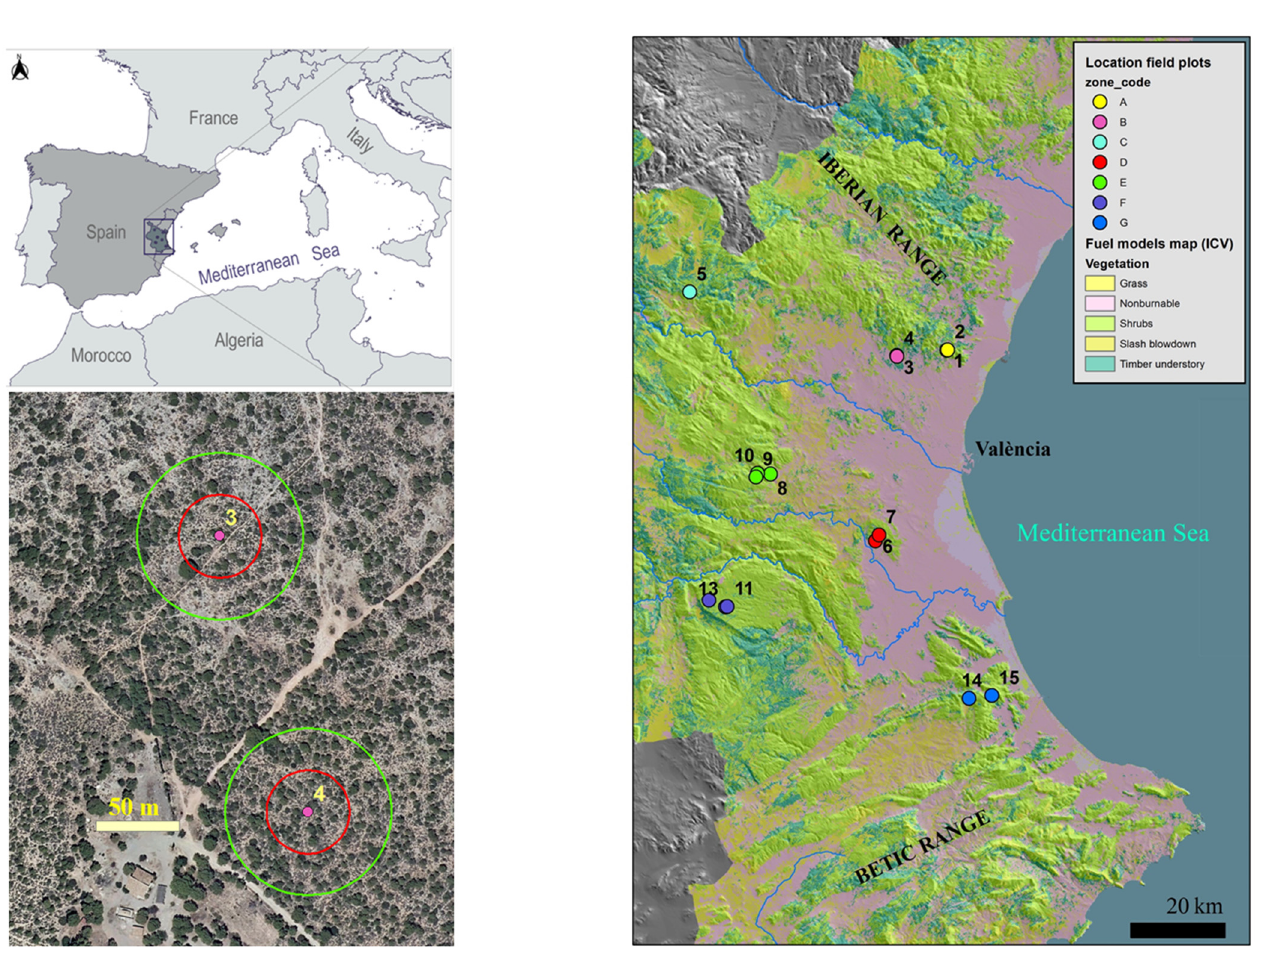
Figure 1. Overall location of the study area (top left); location of field plots and vegetation types (right) (the vegetation map was obtained from http://www.icv.gva.es/auto/aplicaciones/icv_geocat/#/results/incendios, accessed on 12 April 2021); and detail of plots 3 and 4 (bottom left), with the two concentric circles used for field data collection (red) and to ensure homogeneity in the samples from satellite images (green).